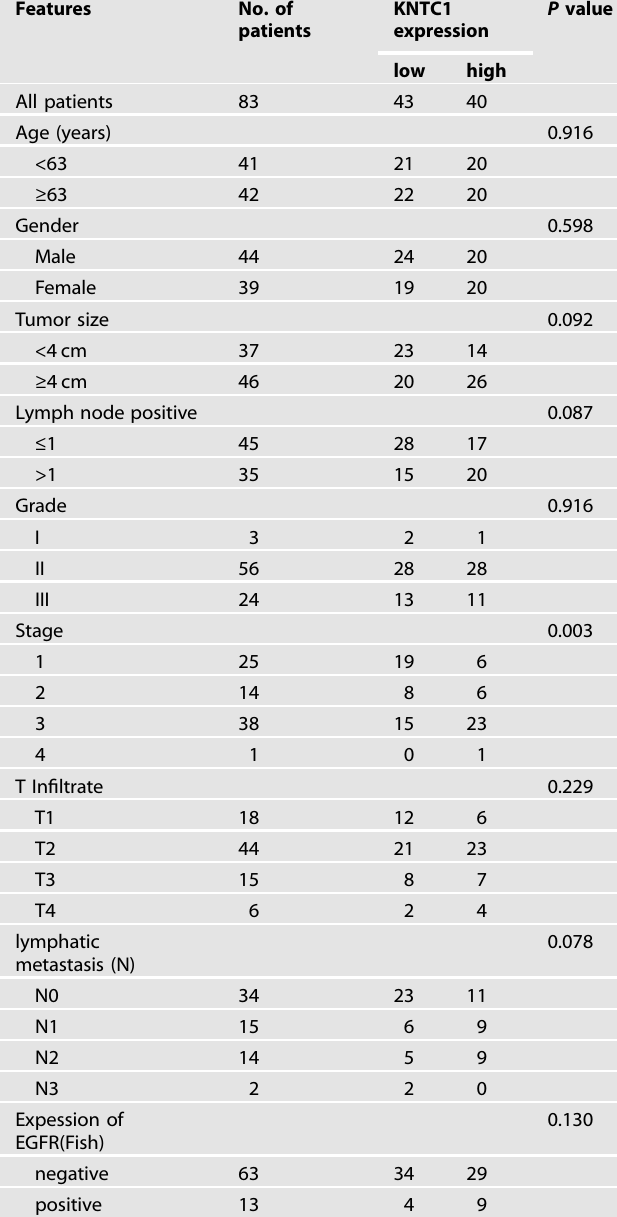
Table 2. Relationship between KNTC1 expression and tumor characteristics in patients with